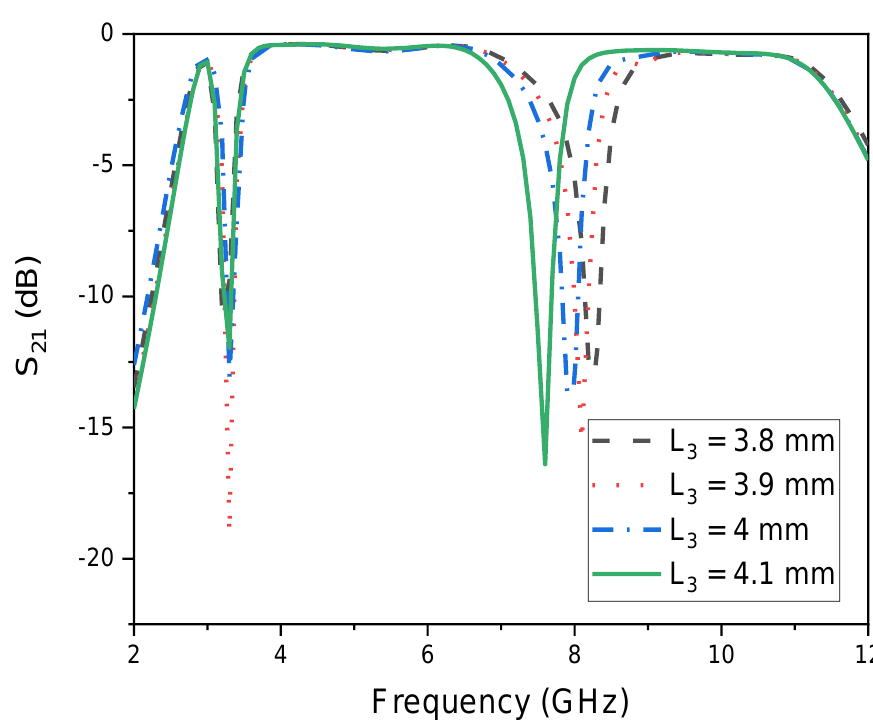
Figure 15. S 21 plot of second band control with parameter L 3 .